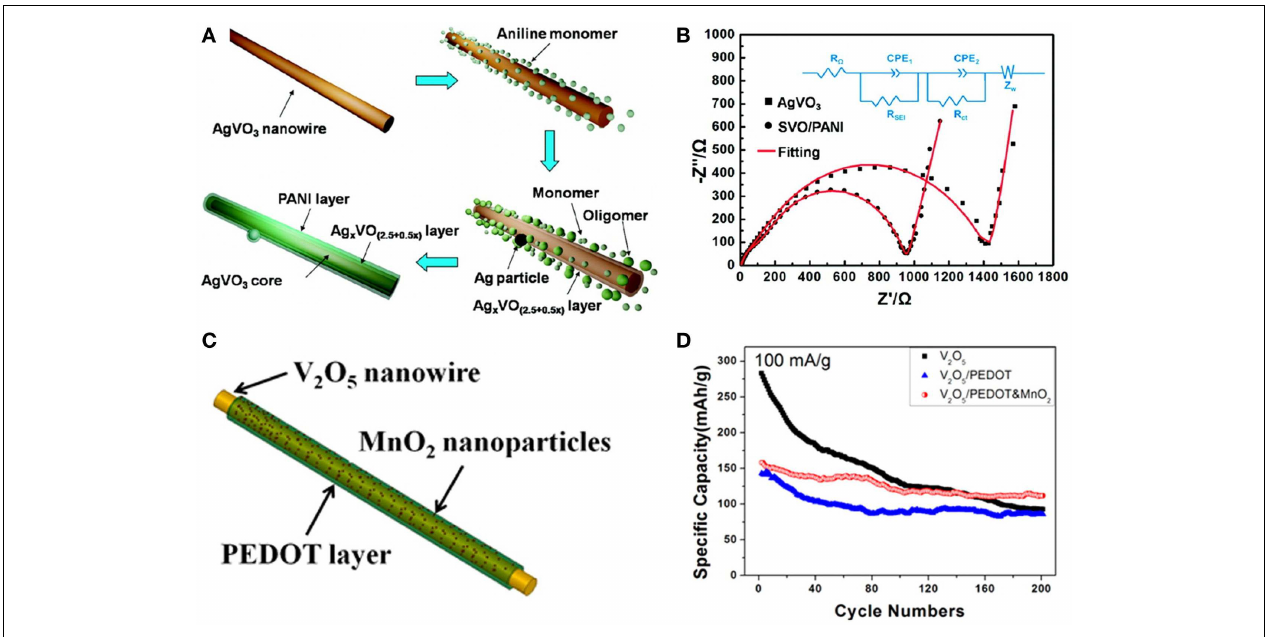
V 2 O 5 NWs,V 2 O 5 /PEDOT NWs, andV 2 O 5 /PEDOT&MnO 2 NWs (Mai et al., 2013a). Reprinted with permission from Mai et al. (2011b) and Mai et al. (2013a). Copyright 2011 American Chemical Society, and 2013 American Chemical Society.